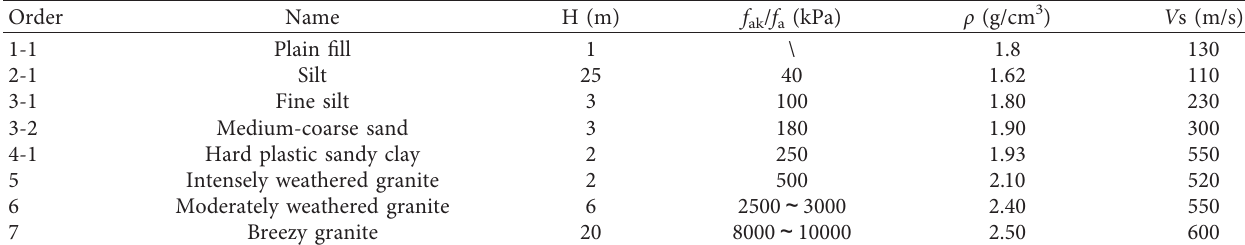
Table 2: Soil parameters of soft soil